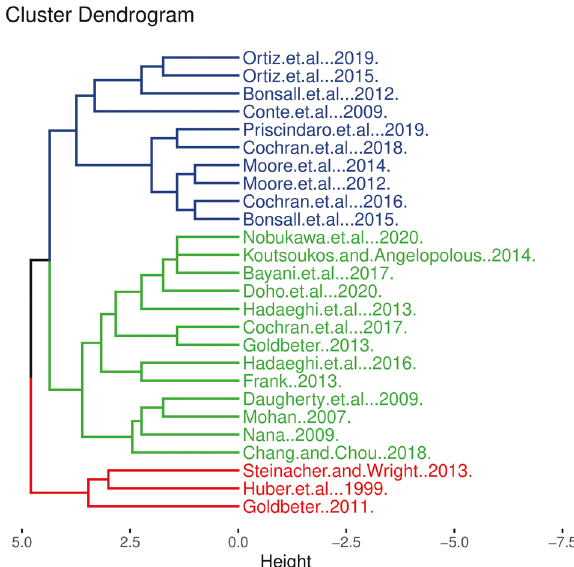
Fig. 2 Dendrogram-based depiction of paper clustering according to results on the validity appraisal guide. Cluster 1 corresponds to largely data-driven models that showed strong face validity. Cluster 2 corresponds to studies presenting theory-driven models with predictive validity. Cluster 3 corresponds to studies presenting theory-driven models that largely lacked face, predictive, and construct